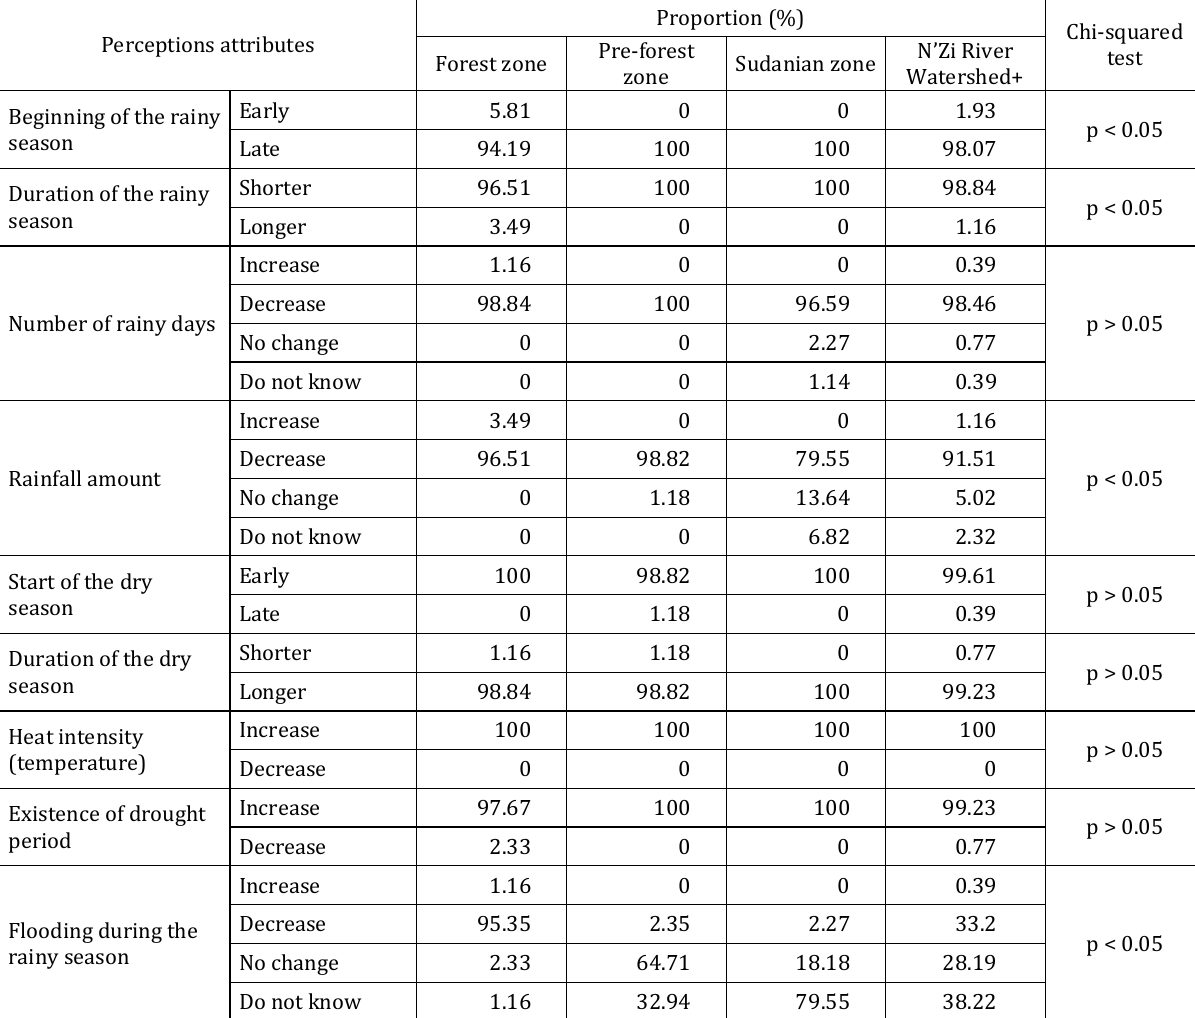
Table 3. Perceptions of farmers on changes in climate patterns